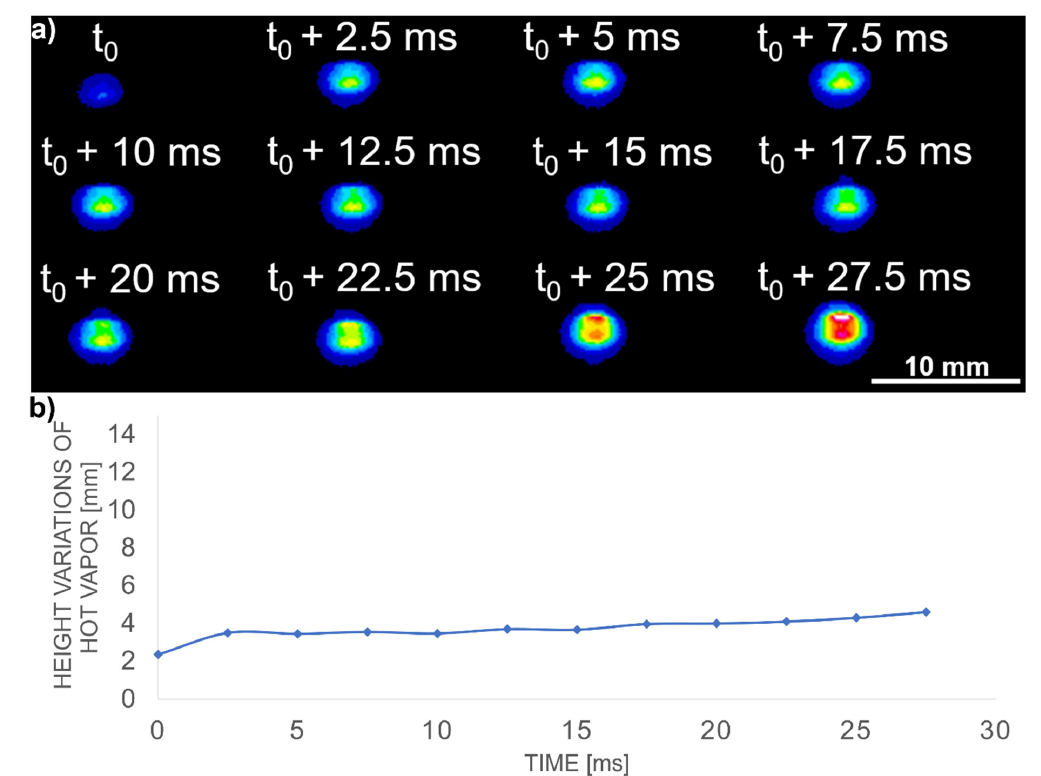
Figure 5. ( a ) High-speed camera images and ( b ) plot of hot vapor plume height variation in time for each presented frame in case of AlMg3 alloy.